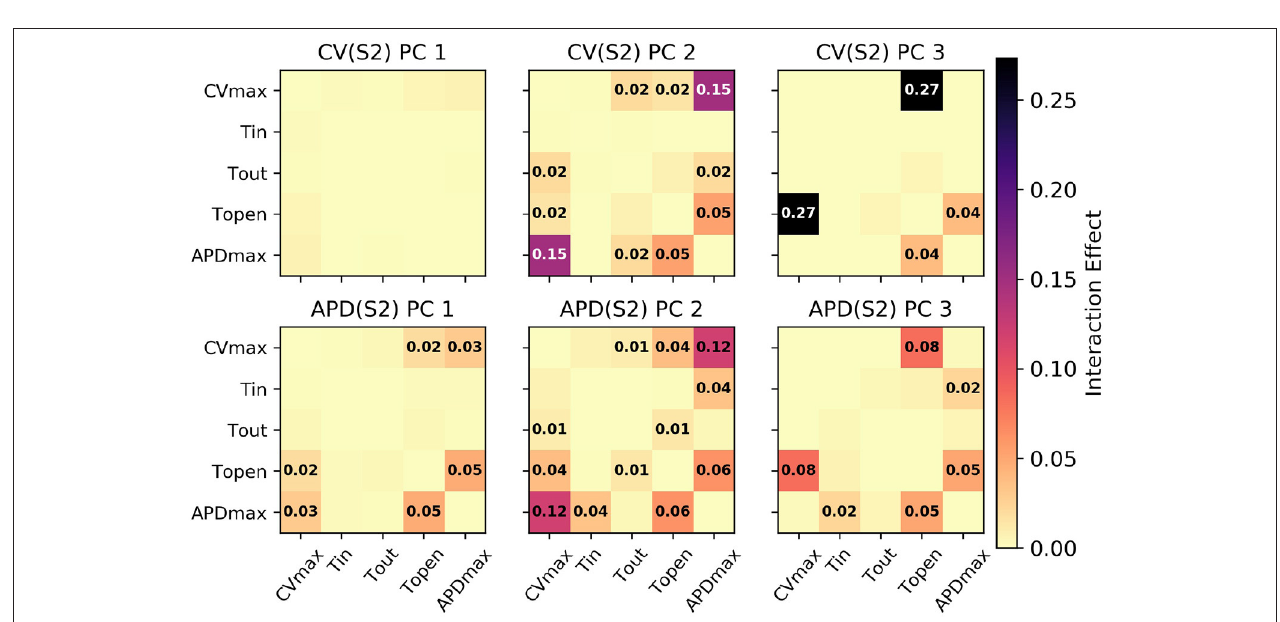
FIGURE 5 | Second-order interaction effects for S1: 600 ms, with text labels applied in cells where the effects are at least 0.01 (i.e., account for at least 1% of the overall variance).